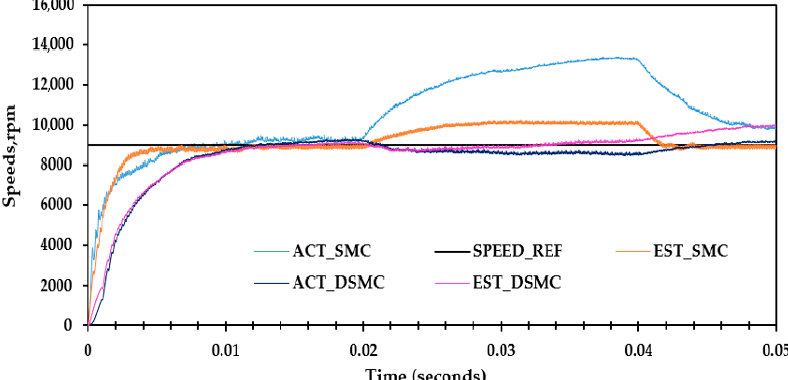
Figure 27. Decrements of the moment of inertia by 10%. [Note: ACT_SMC: actual speed under sliding mode controller; EST_SMC: estimated speed under sliding mode controller; ACT_DSMC: actual speed under dynamic sliding mode controller; EST_DSMC: estimated speed under dynamic sliding mode controller; SPEED_REF: reference speed]